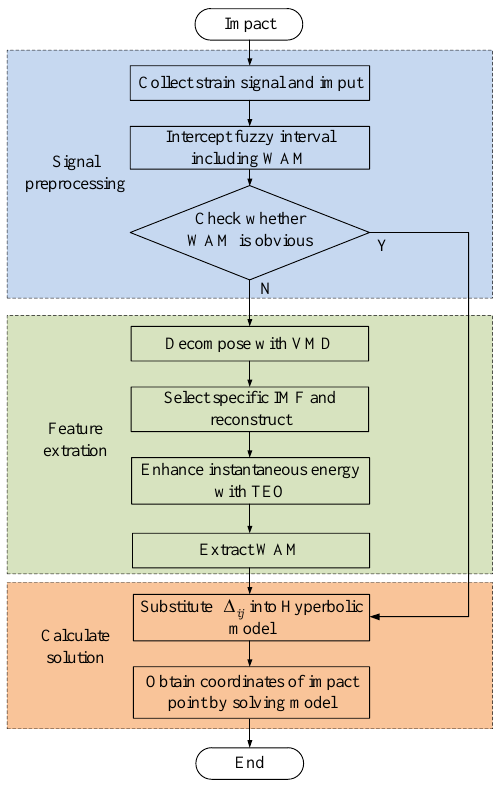
Figure 3. Flow diagram of the proposed approach.